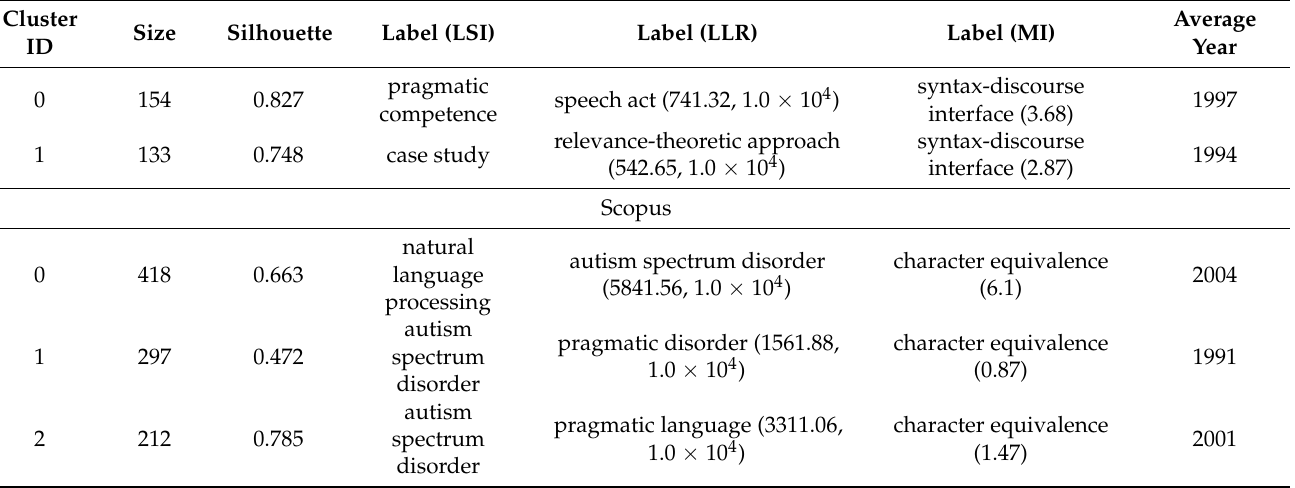
Table 4. Major pragmatics